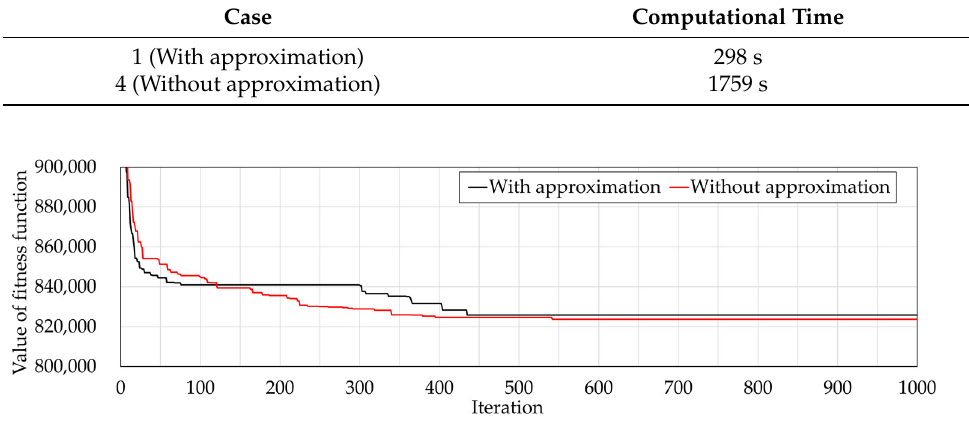
Figure 10. Transitions of gbest in Cases 1 and